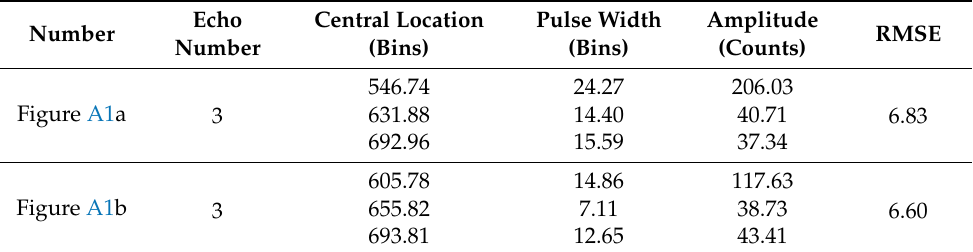
Table 2. Matlab terrestrial LiDAR echo decomposition